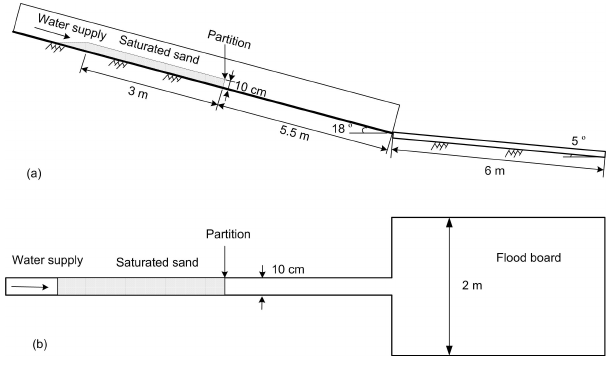
Figure 10. Experiment setup in Test 4: (a) side view, (b) top view.